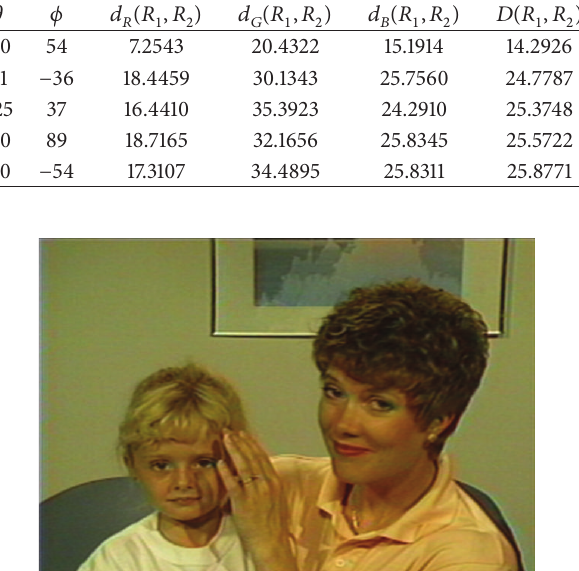
Figure 11: Frame 2 in